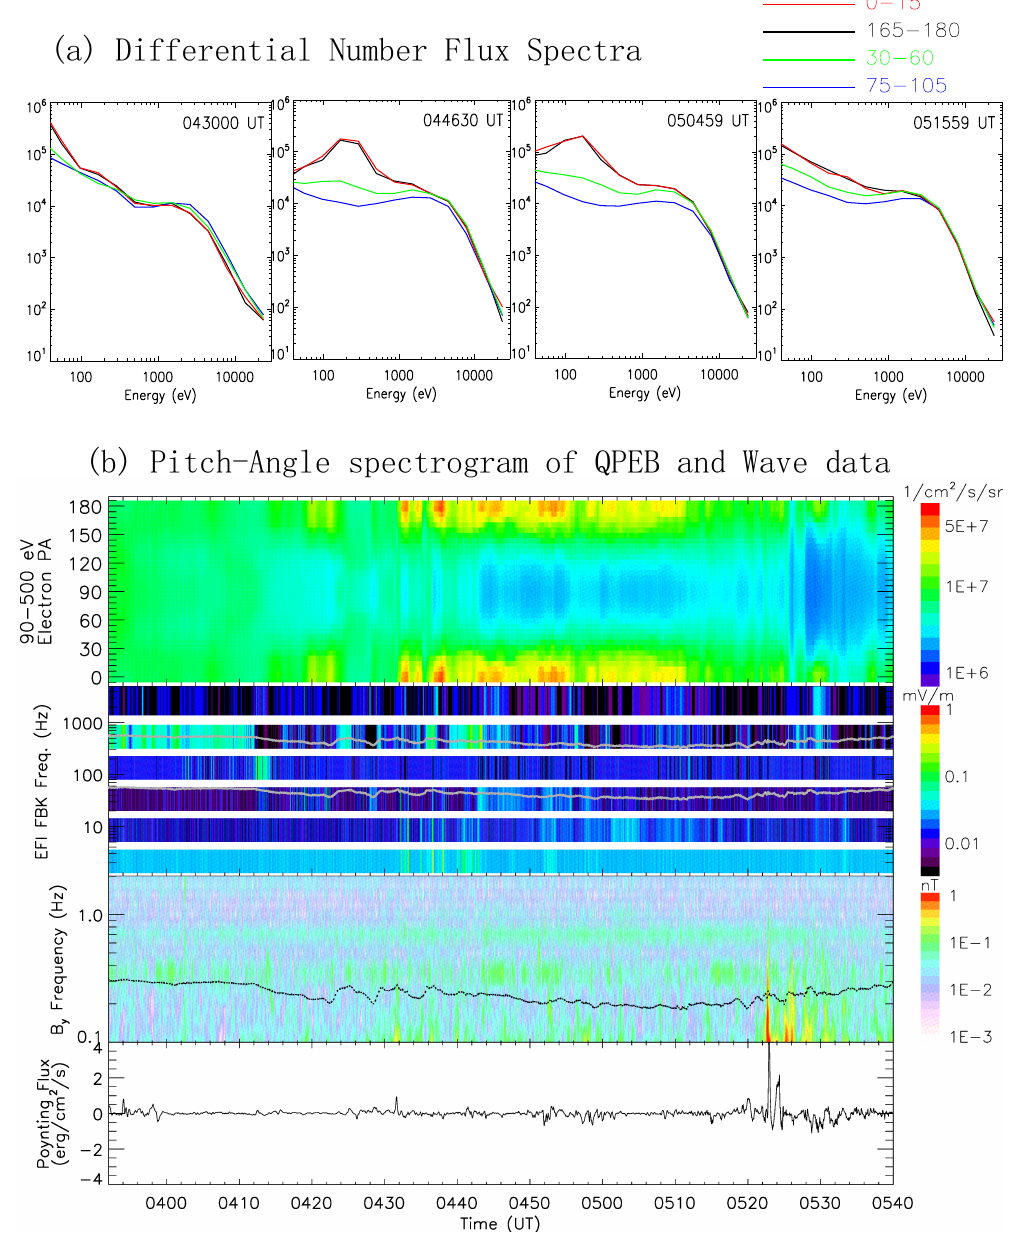
Fig. 5. (a) A few slices of the differential number flux spectra in parallel, antiparallel, oblique, and perpendicular directions, exemplifying the feature and evolution of the QPEB. The color code for the pitch-angle direction is labeled in the plot. (b) The top panel shows the pitch- angle spectrogram of 90–500eV electrons; the second panel shows the FBK data of EFI measurements; the third panel shows the wavelet scalogram of the B y component from FGL dataset. The gray curves in the second and third panels denote f ce , 0 . 1 f ce , and f ci , from high to low frequencies. The bottom panel shows the parallel Poynting flux mapped to the